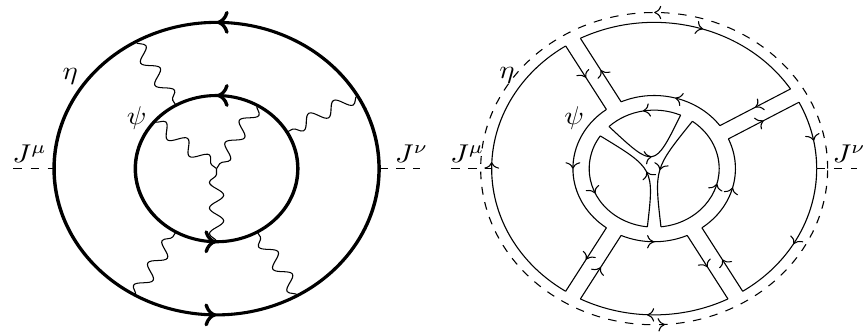
Figure 1 . A leading N planar graph for the two-point function h 0 | T { J µ ( x ) J ν (0) }| 0 i with an η ∗ ψ ∗ ψη intermediate state (figure 1a, left). On the right figure (figure 1b) the color (full) and flavor (dashed) lines are shown. The wavy lines inside the graph are the gluons.